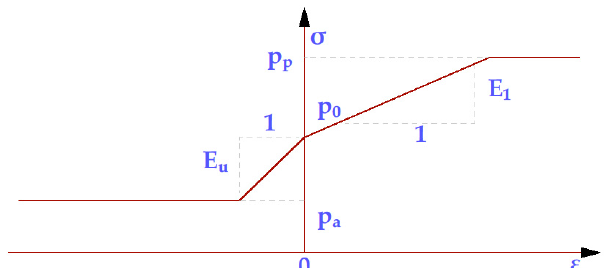
Figure 7. Generic stress–strain constitutive model-specific deformation for all three types of soils used in the numerical model (loose sand, compacted sand, saturated clay).